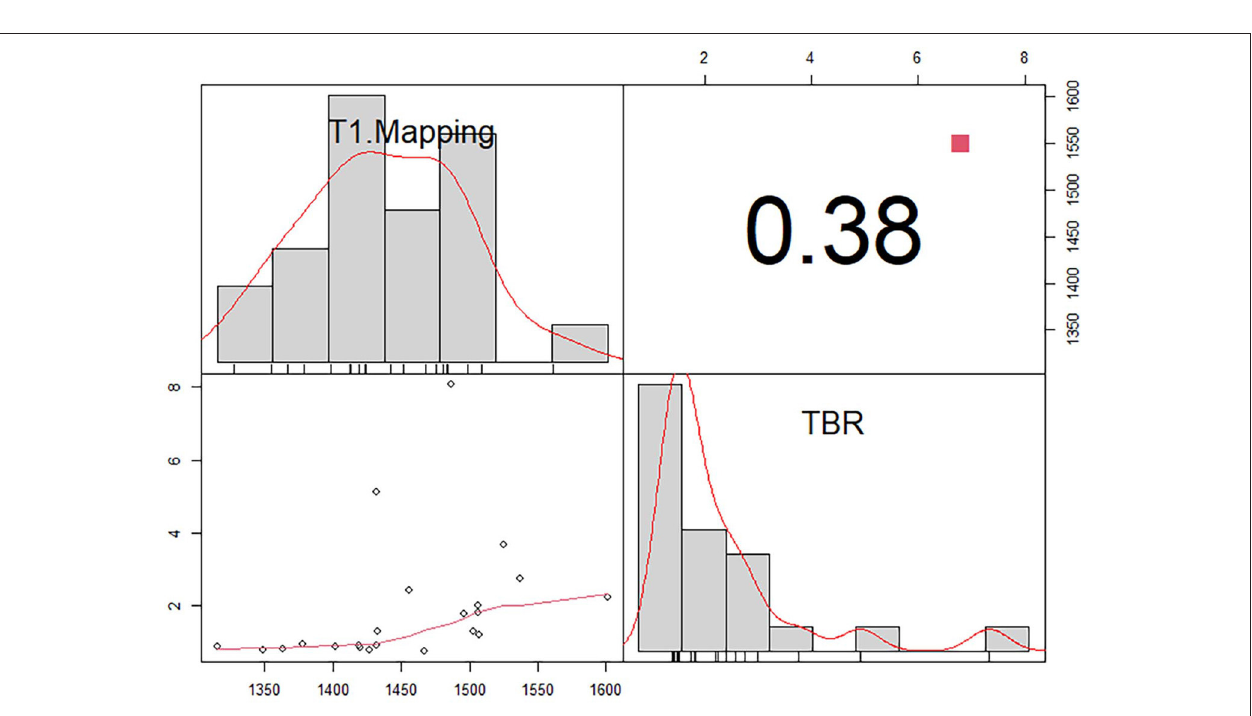
FIGURE 4 | Correlation between T1 mapping and maximum target-to-background ratio (TBR) in patients with (CA) and without cardiac amyloidosis (non-CA).There is a positive correlation between native T1 mapping value and TBR in CA and non-CA patients ( r = 0.38, P = 0.0004). TBR and ECV was 99%. Native T1 showed higher sensitivity (100 vs. 94%) and lower specificity (94 vs. 100%) than TBR and